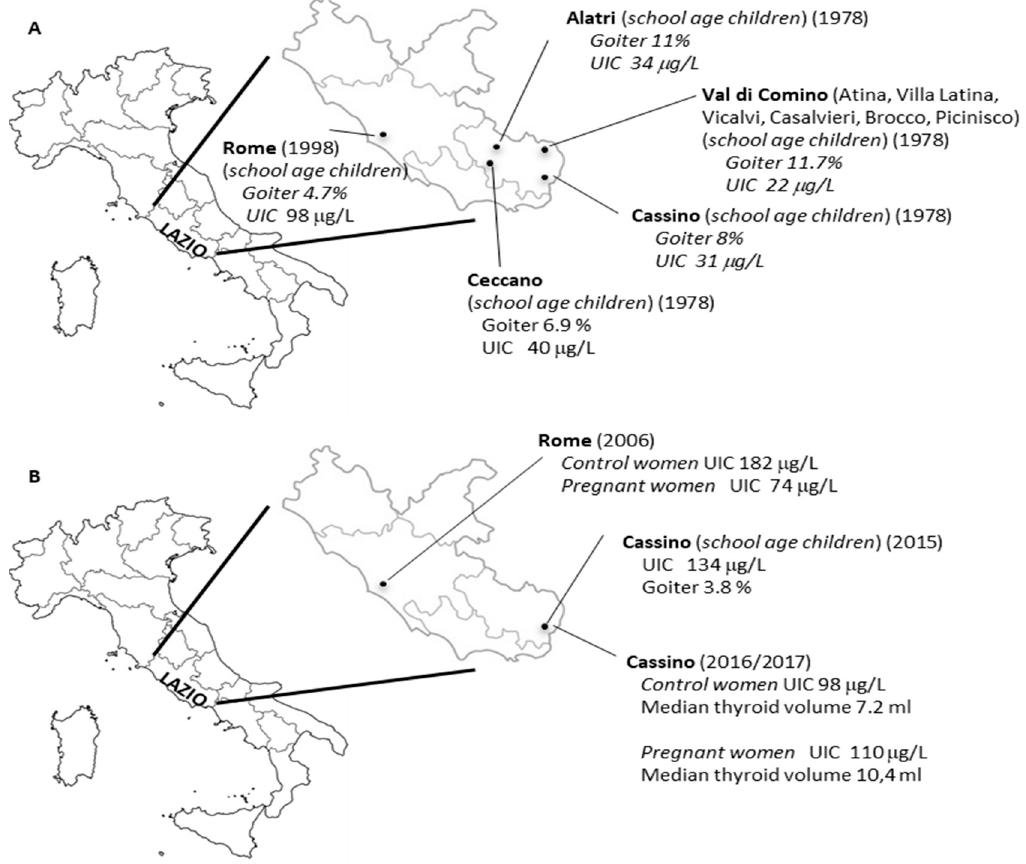
Figure 1. Urinary iodine concentrations (UIC) and goiter prevalence in the inhabitants of Lazio before ( A ) and after ( B ) the introduction of the national salt iodination program.